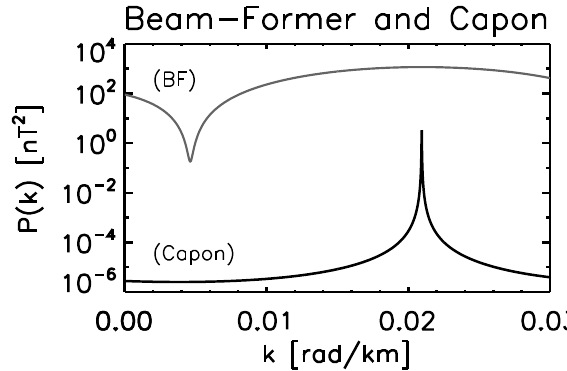
Fig. 1. Wave number spectra evaluated by the beam-former (BF) and Capon’s projection